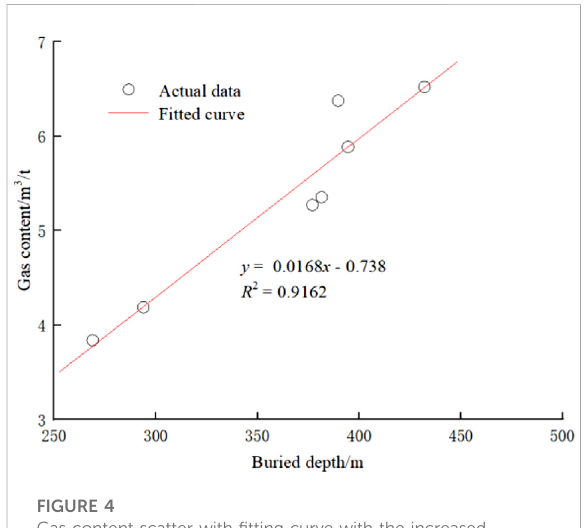
FIGURE 5 Gas content scatter with fi tting curve with the overburden thickness in district